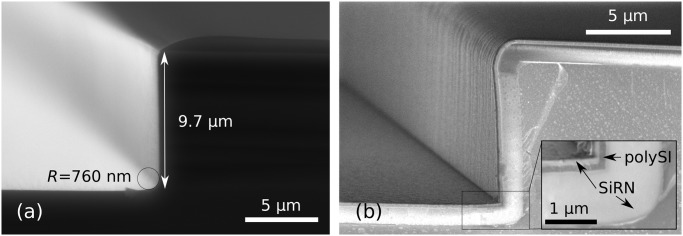
First steps of 90° complex hinges fabrication.(a): Cross section of a mold obtained by dry etching of silicon. The corner is not exactly perpendicular (measured to be 89°) and the process yields a round corner. These parameters can be modified by fine tuning the dry etching step. Note that photoresist is still present on top. (b): Stack of the three layers necessary for corner lithography: thick SiRN (1070 nm), polySi (around 150 nm) and a second layer of SiRN (146 nm).